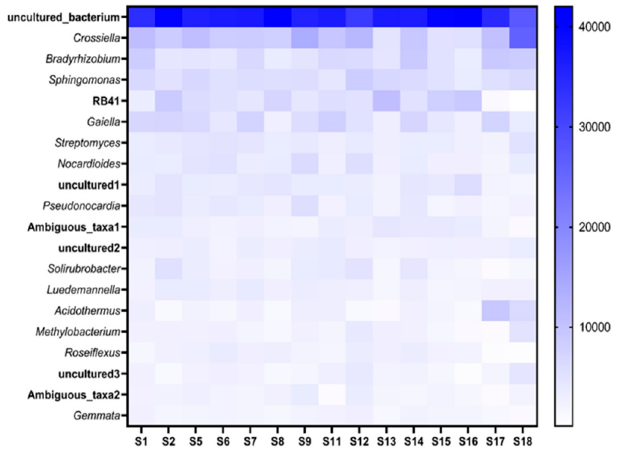
Figure 7. Heatmap indicating the top 20 bacterial genera and their abundance associated with the soybean rhizosphere of the 15 fields (S1–S18). The darkness of the blue color indicates the abun- dance, with darker colors being more abundant.